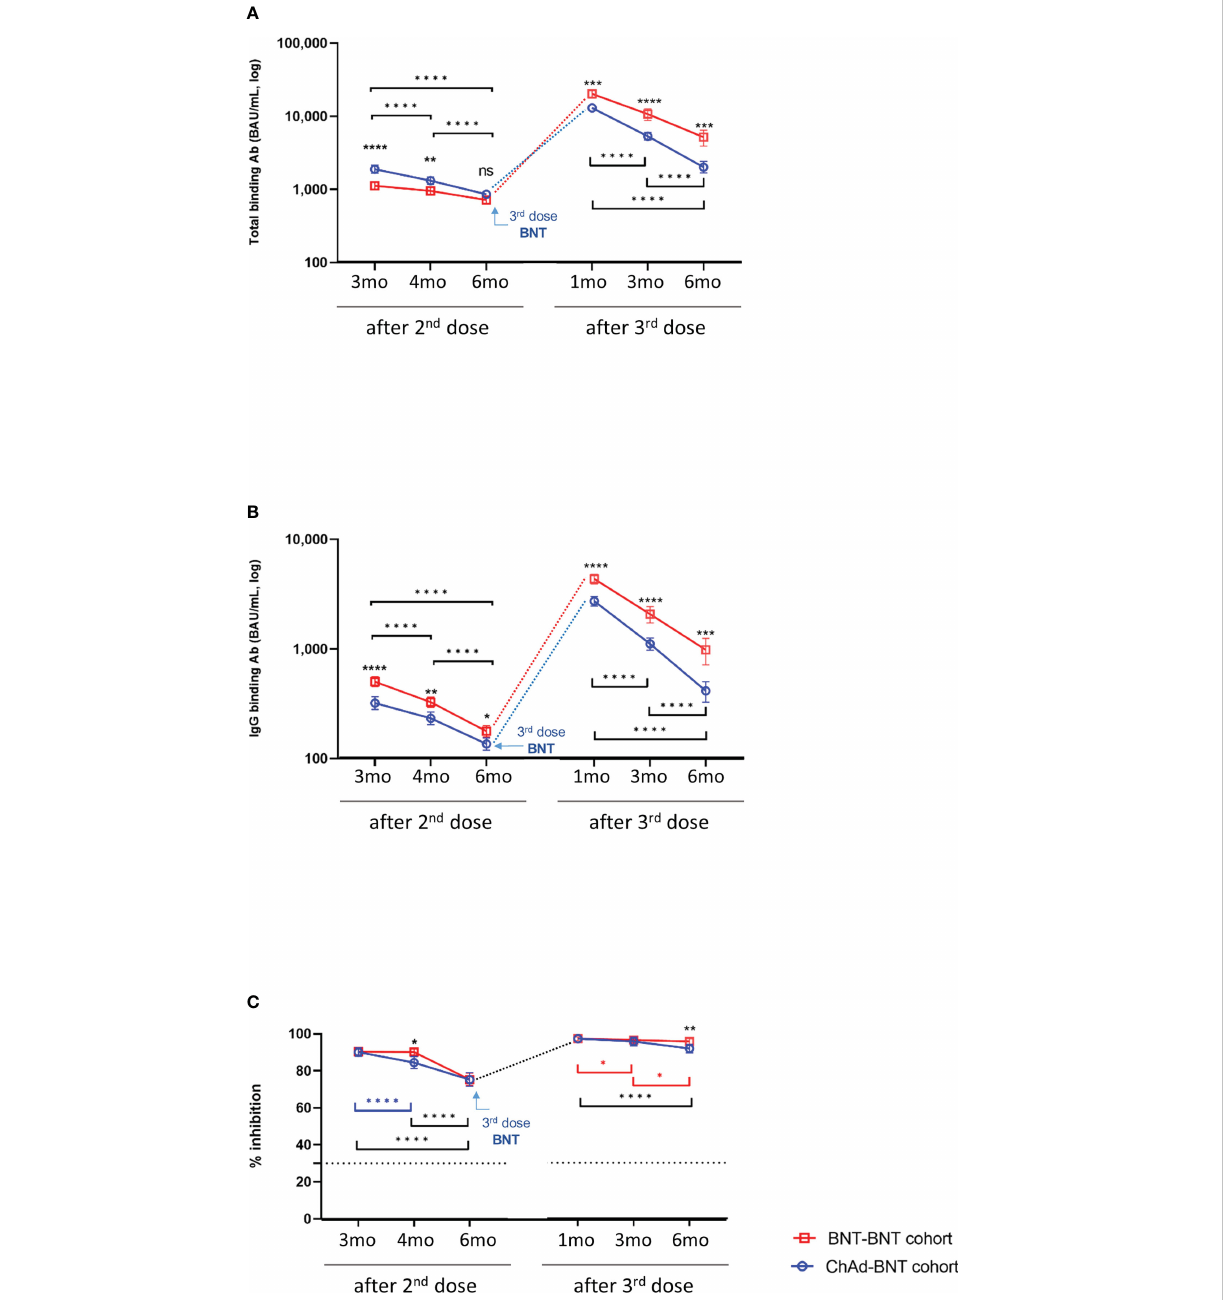
FIGURE 2 Binding antibody and neutralization responses in infection-naïve participants. SARS-CoV-2 spike-speci fi c total binding antibody titer (A) and IgG binding antibody (B) and % inhibition by surrogate virus neutralization test (C) are shown. Data are presented as geometric mean with 95% con fi dence interval. The statistical signi fi cance was calculated using repeated measure two-way ANOVA with Sidak ’ s multiple comparisons test. When the ChAd-BNT cohort and BNT-BNT cohort revealed signi fi cant differences, the signi fi cance is expressed either over the blue circle or over the red square. When signi fi cant change was observed over a certain period, it is expressed using ticked lines (blue: Chad-BNT cohort, red: BNT-BNT cohort, black: both cohorts). The assay cut-off is presented as a horizontal dotted line. ns, not signi fi cant; * P <0.05; ** P <0.01; *** P <0.001; **** P <